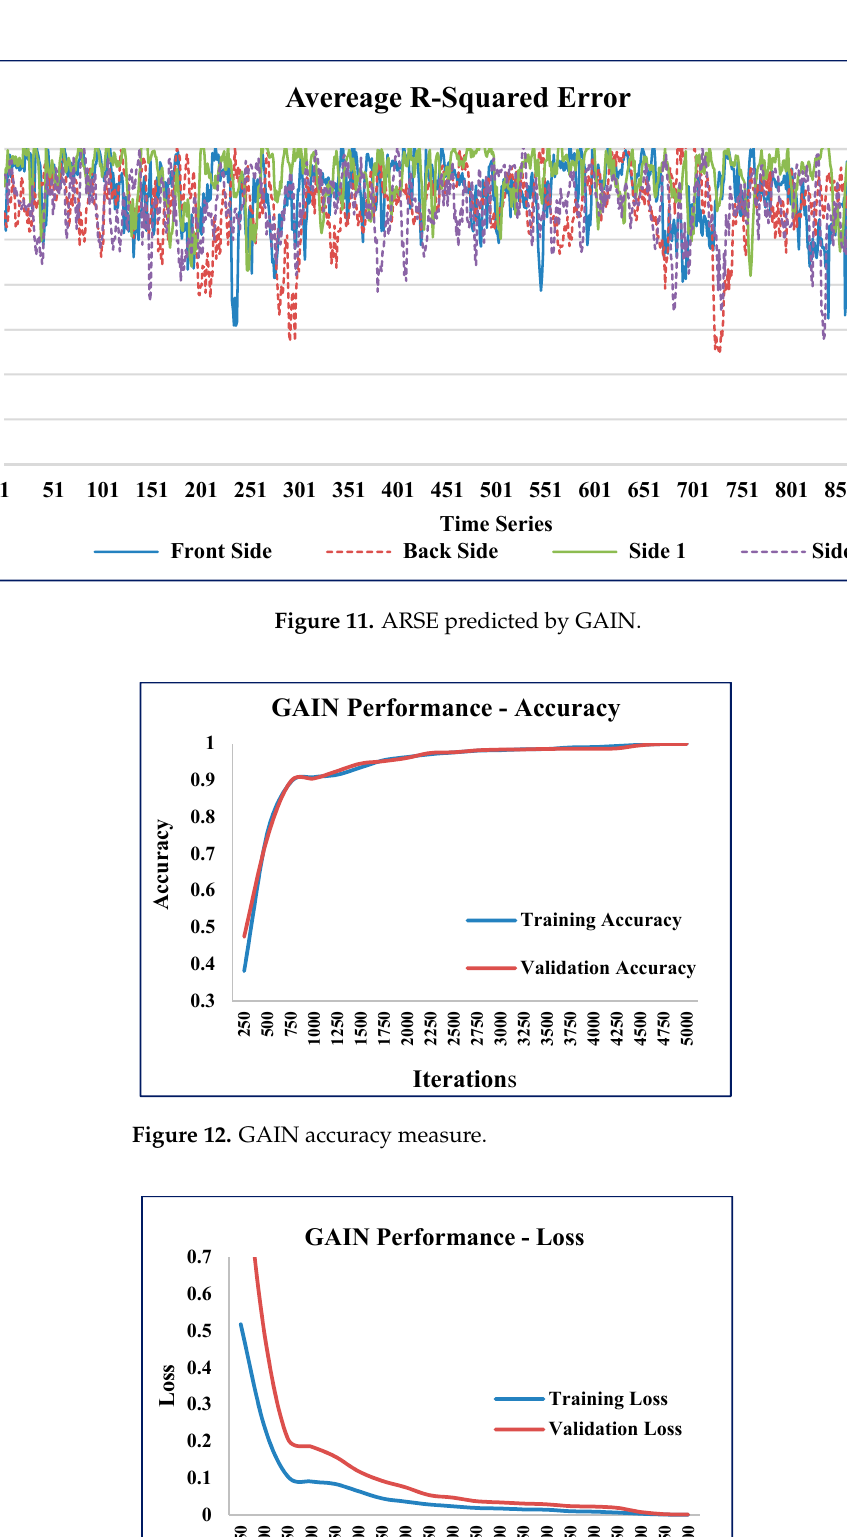
Figure 10. AMSE predicted by GAIN.